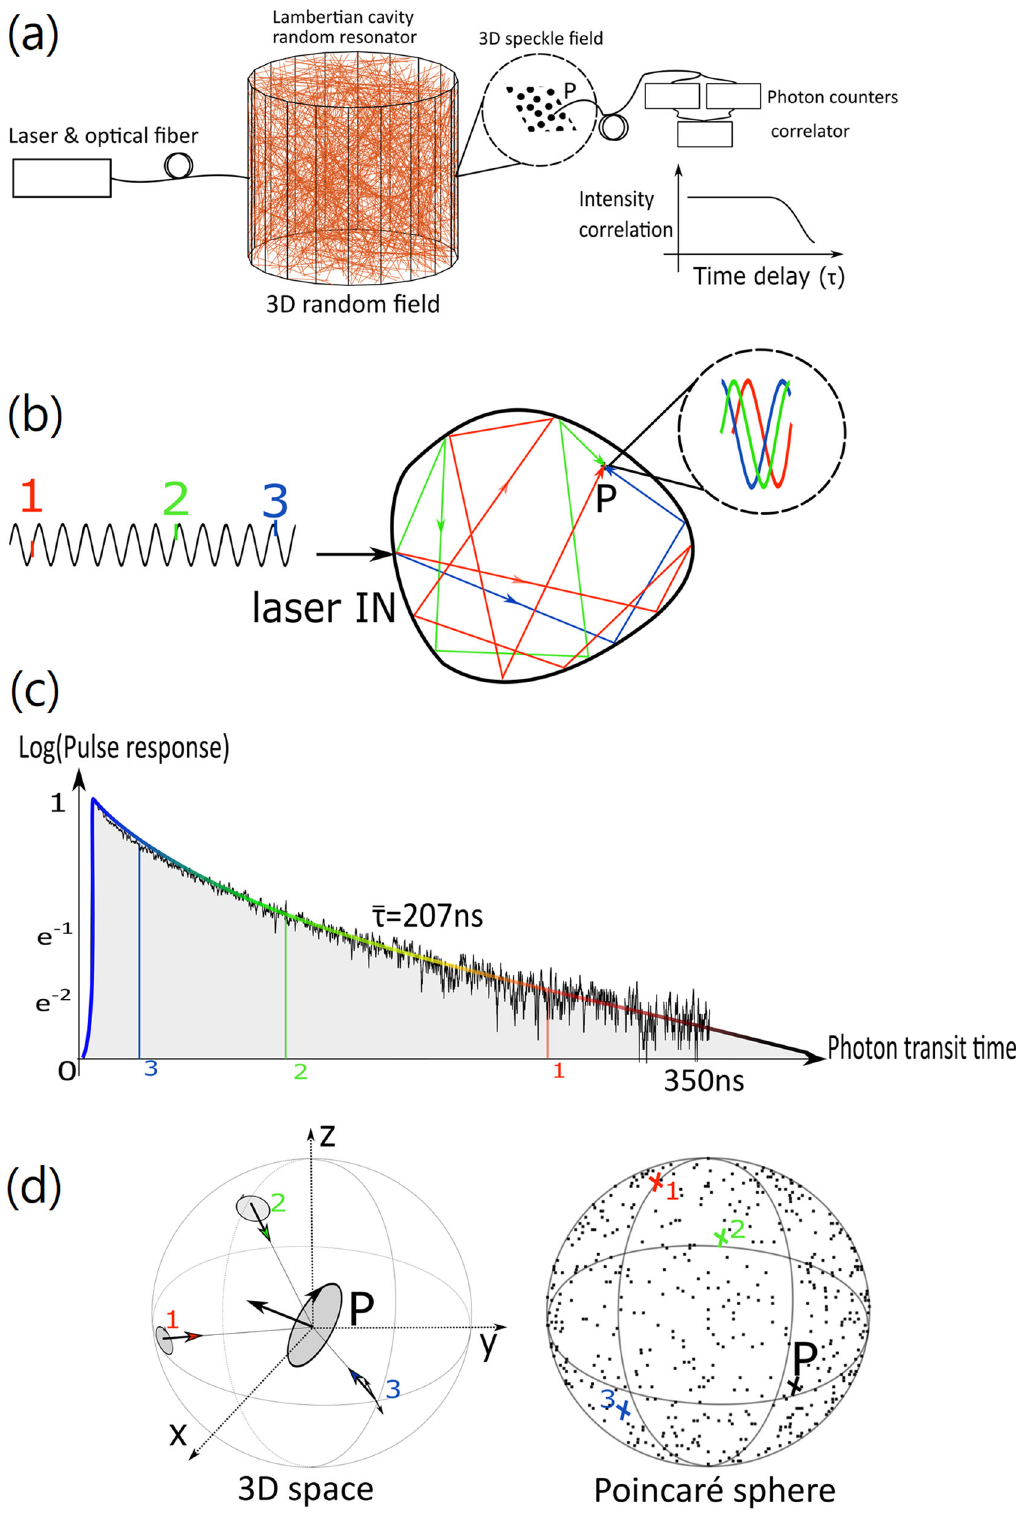
Fig. 1 3D stochastic interferometer construct. a Experimental setup: a single-frequency laser is injected by an optical fi ber into a high re fl ectivity Lambertian cavity. Regardless of the cavity shape, the resulting 3D random fi eld is fully coherent and generates a fully developed 3D speckle pattern which is probed at point P by a single mode fi ber. The fi ber is split, and the intensity is detected by 2 photon counters. The intensity cross-correlation is then calculated by a digital correlator. b Schematic representation of three generic path photons or modes, as a succession of diffuse re fl ections, between the laser input and a probe point P. c Intensity response function of a compressed quartz powder cavity to a 120 ps laser pulse at 670 nm represented in a y -log scale. d Coherent superposition of 3 plane waves at point P, with their respective complex polarization and Poincaré sphere representing the uniformly and randomly distributed polarizations of the plane waves interfering at point P. In particular, the polarization states of the aforementioned 3 plane waves are represented, as well as the 2D polarization state of the wave generated at point P. COMMUNICATIONS PHYSICS| (2022) 5:239